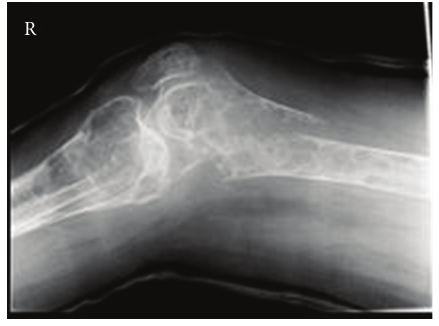
a ff ecting the gene DAP 12 located on chromosome 19q13.1.